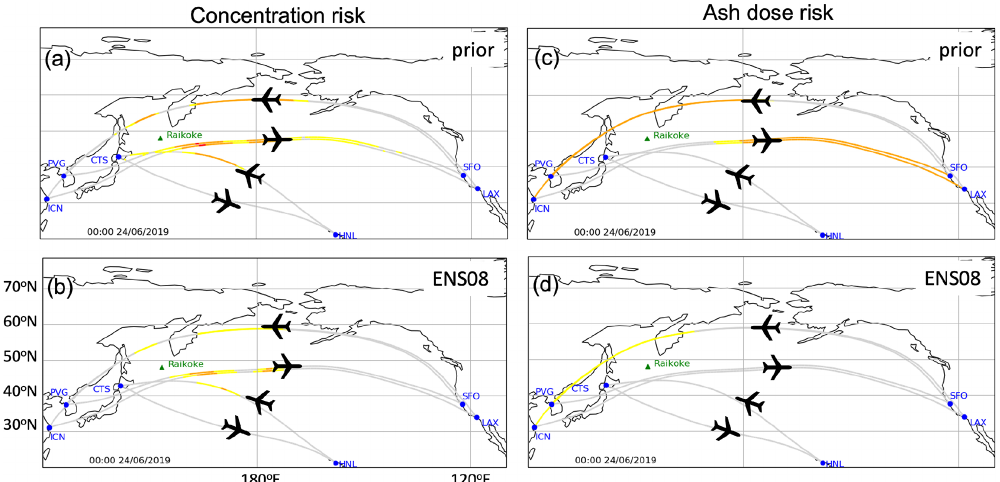
Figure 9. Concentration risk along time optimal flight routes at 00:00UTC on 24 June 2019 for (a) prior ensemble (b) ENS08. Ash dose risk along the same time optimal flight routes at 00:00UTC on 24 June 2019 for (c) prior ensemble (d) ENS08. Yellow shading indicates the lowest level of risk, orange shading indicates mid-level risk, and red indicates the highest level of risk. Note that dose risk only considers risk at FL350–550, whereas concentration risk considers at all